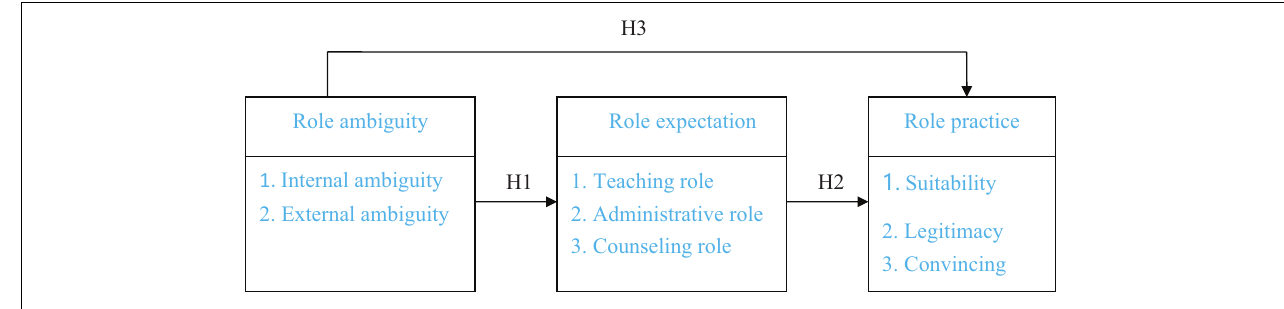
FIGURE 1 | Conceptual